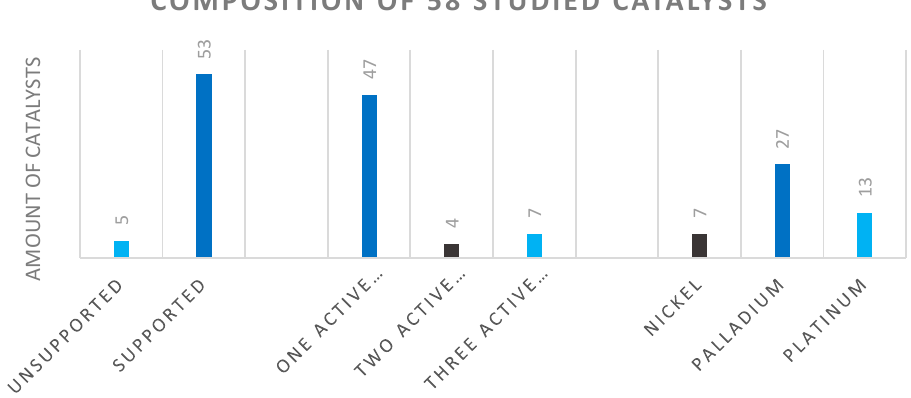
Figure 9. Composition of studied catalysts according to support, active component.